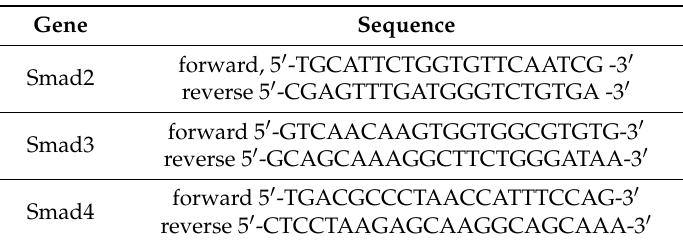
Table 2. Sequences of PCR primer used in this